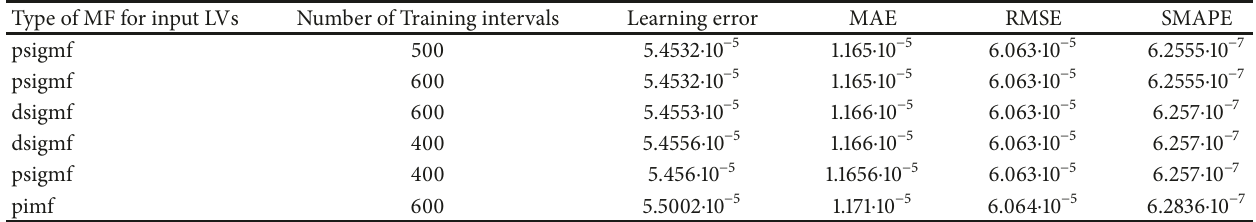
Table 1: Resulting simulation modelling of the neural-fuzzy ship collision prevention system in the grating generation without clustering. Type of MF for input LVs